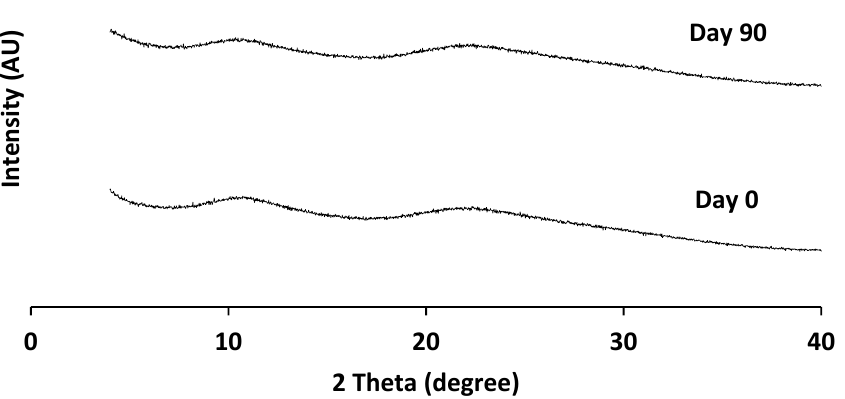
Figure 9. X-ray diffraction patterns of naproxen-PVP dispersions prepared by 3FN using acetone as a solvent for both drug and polymer, when measured immediately after spray drying (Day 0) and after 90 days of storage at 75% RH at 25 °C.